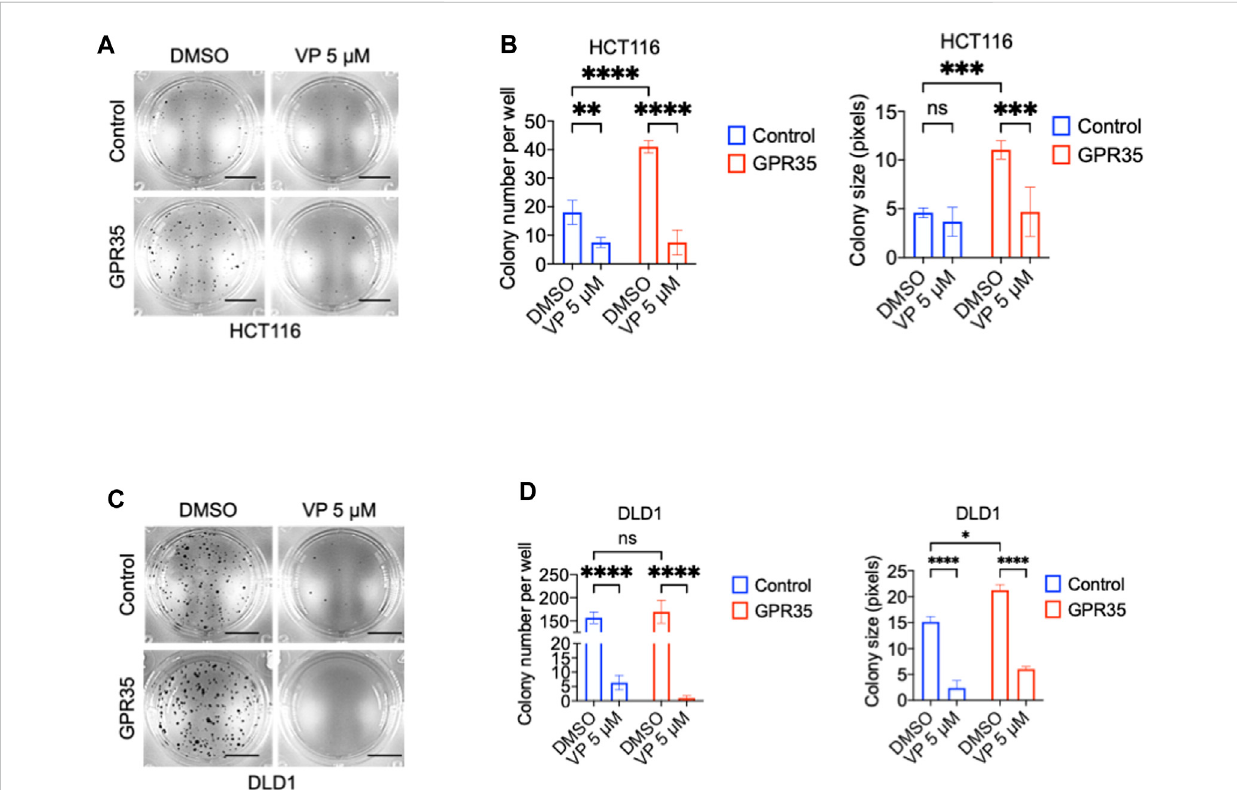
FIGURE 7 YAP/TAZactivitywasrequiredforanchorage-independentgrowthofCRCcells. (A,B) Representativemicroscopicimagesandquanti fi cationanalysis of colony formation assay ( n = 3) of HCT116 cell lines in soft agar assay. Scale bars: 0.5 cm. (C,D) Representative microscopic images and quanti fi cation analysis ofcolony formationassay ( n =3)ofDLD1cell linesinsoftagarassay.Scalebars:0.5 cm. Vertepor fi n5 μ Mwasused, andtheculturemedium was replaced every 3